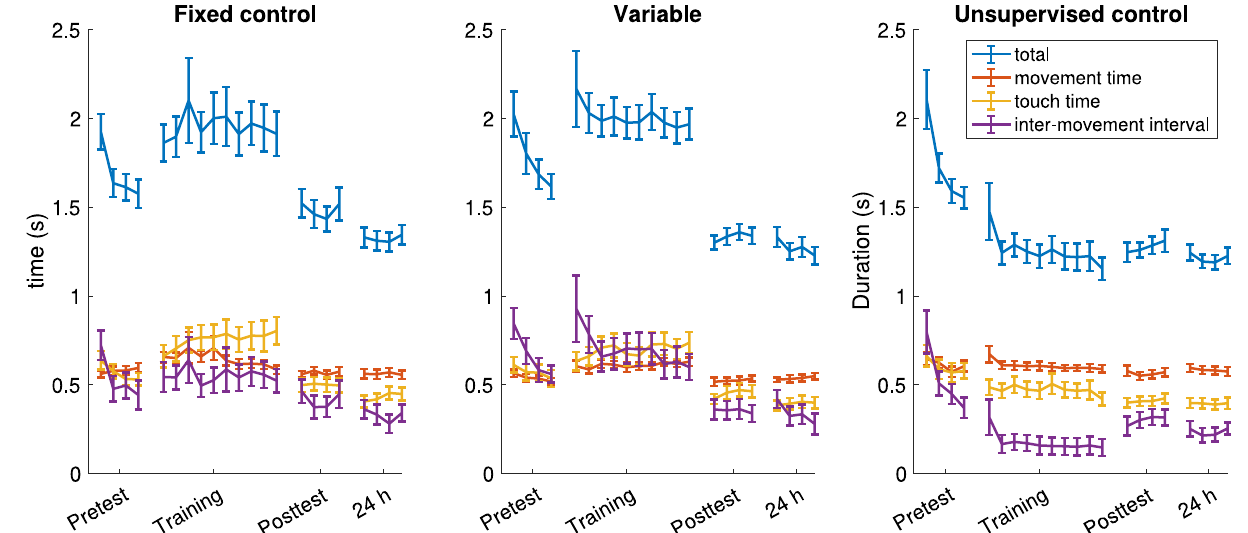
Figure 5. Decomposition of the sequence duration into parts. Each point is the mean value of the quantity in a given trial (4 trials during Pretest, Posttest and 24 h, 10 trials during training). Note that the total time does not include inter-movement interval between sequences, because the sequences were not performed continuously during training. Values shown are the means, error bars are the standard